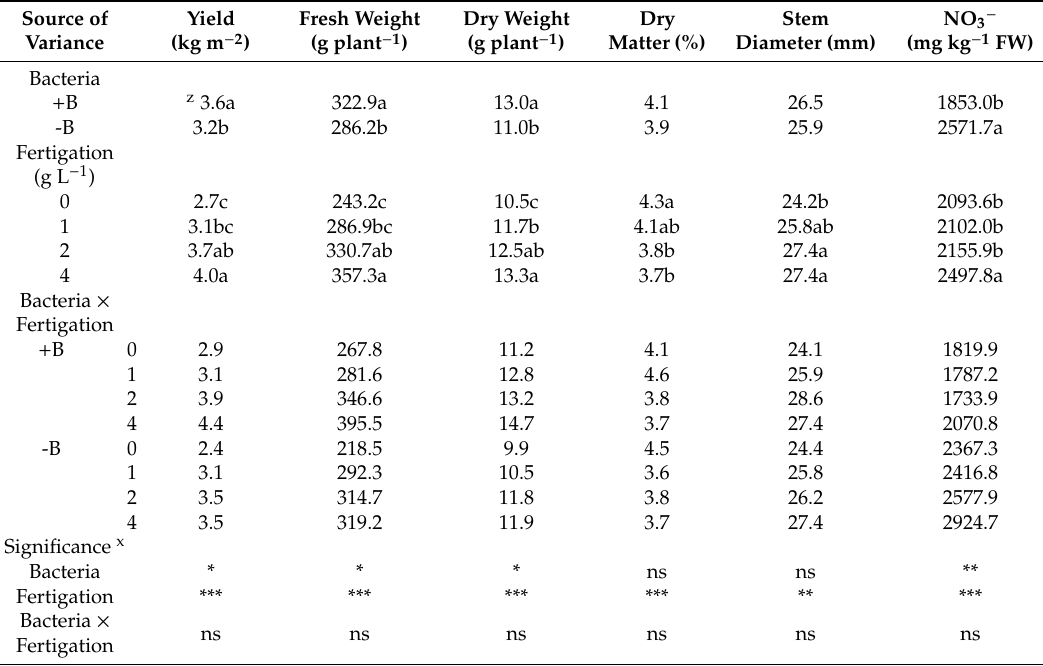
Table 3. E ff ects of the bacterial biostimulant (-B, not inoculated; + B, inoculated) and fertigation rate (g L − 1 of NPK 20-20-20) during transplant production on yield and yield components of lettuce plants grown in a tunnel-greenhouse.